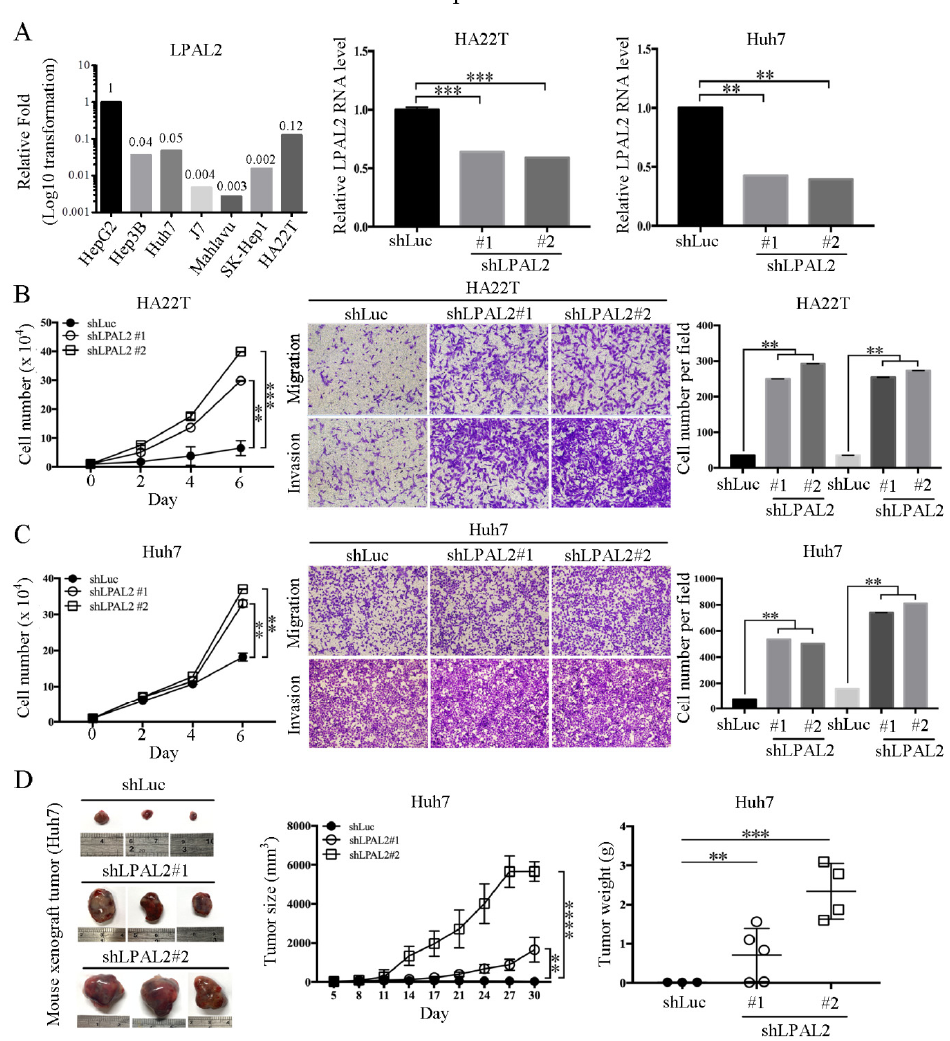
Figure 2. Knockdown of LPAL2 accelerates tumor growth, migration, and invasion. ( A ) Left panel: Endogenous expression level of LPAL2 in hepatoma cell lines (HepG2, Hep3B, Huh7, J7, Mahlavu, SK-Hep1 and HA22T cells) was determined using qRT-PCR. 18s rRNA was used as a loading control. Expression levels of LPAL2 are presented as log10-transformed values. In addition, the average fold-change value in each cell line was also shown. Middle and right panels: Knockdown efficiency of LPAL2 in HA22T and Huh7 cell lines was tested by qRT-PCR. 18s rRNA served as a loading control. **, p < 0.01; ***, p < 0.001. ( B , C ) Cell proliferation, migration, and invasion assays were performed using LPAL2-depleted HA22T and Huh7 cell lines. The migratory or invasive cells were detected by crystal violet staining. **, p < 0.01; ***, p < 0.001. ( D ) Tumor growth rate and tumor weight were determined in nude mice injected with Huh7-shLuc (control, n = 3), Huh7-shLPAL2#1 ( n = 5) or Huh7-shLPAL2#2 ( n = 4) cells, respectively. **, p < 0.01; ***, p < 0.001; ****, p <